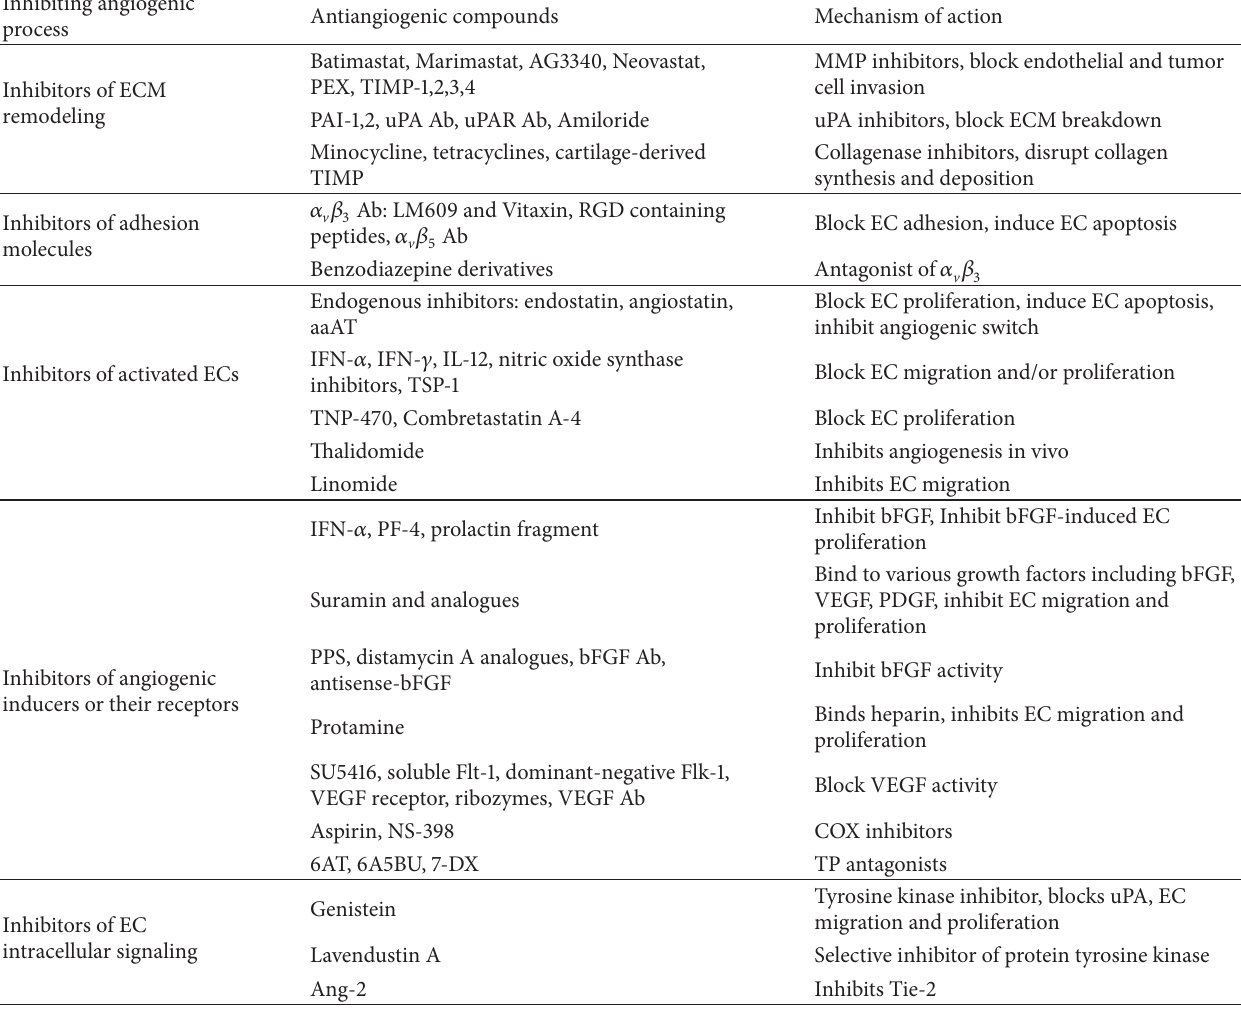
Table 3: Antiangiogenic compounds and their mechanism of action (adapted from references [2, 92–102]). Inhibiting angiogenic